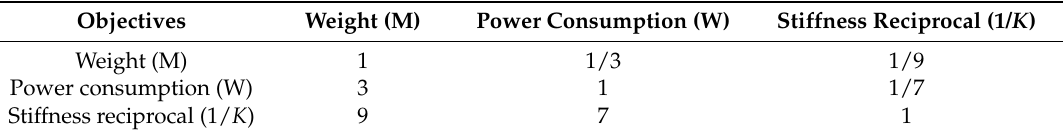
Table 2. The relationship between the objectives.